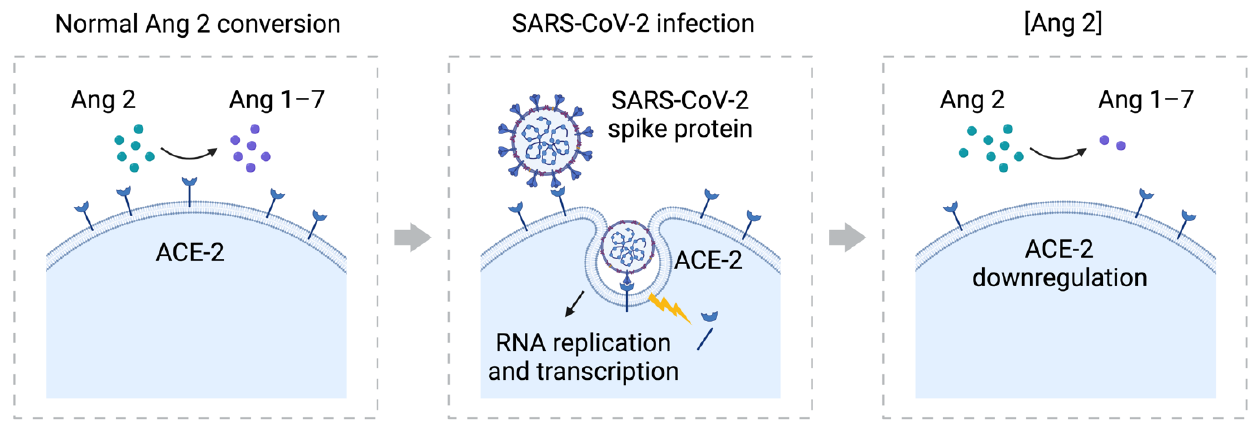
Figure 3. The role of SARS-CoV-2 spike protein in the downregulation of ACE-2 . ACE-2 converts angiotensin 2 to angiotensin 1–7 as part of the RAAS system. The SARS-CoV-2 spike protein binds to the ACE-2 receptor to fuse with the cell and start RNA replication and transcription. This leads to the downregulation of ACE-2, an increase in angiotensin 2, a decrease in angiotensin 1–7, and eventually vasoconstriction